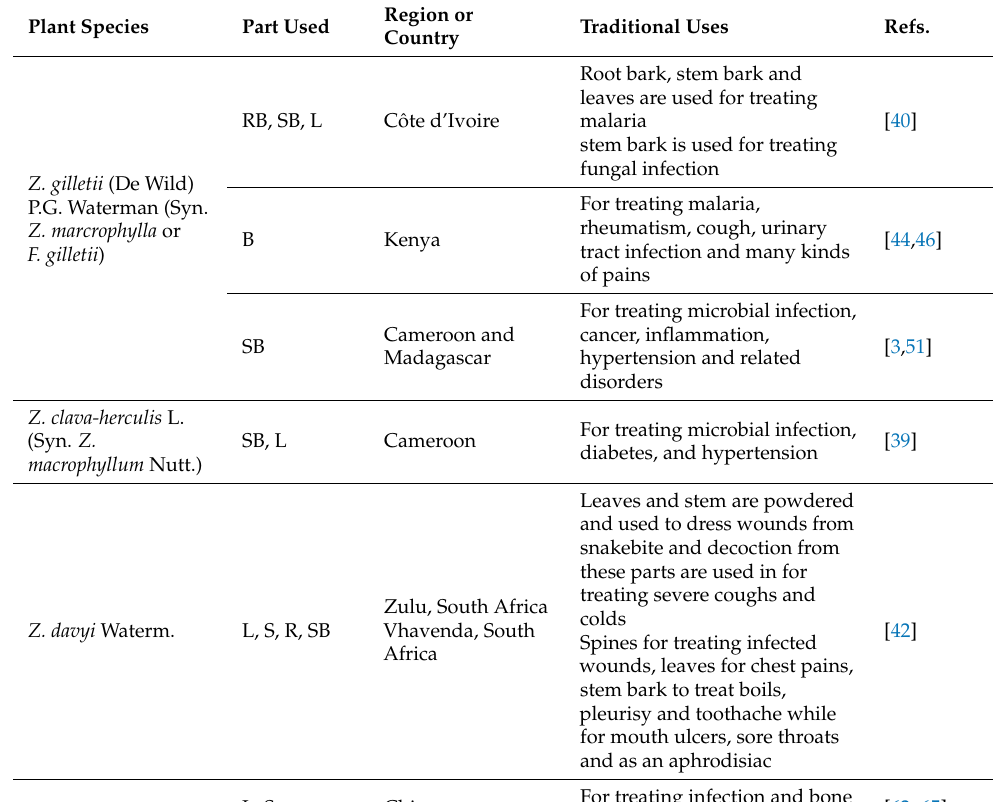
Region or Country